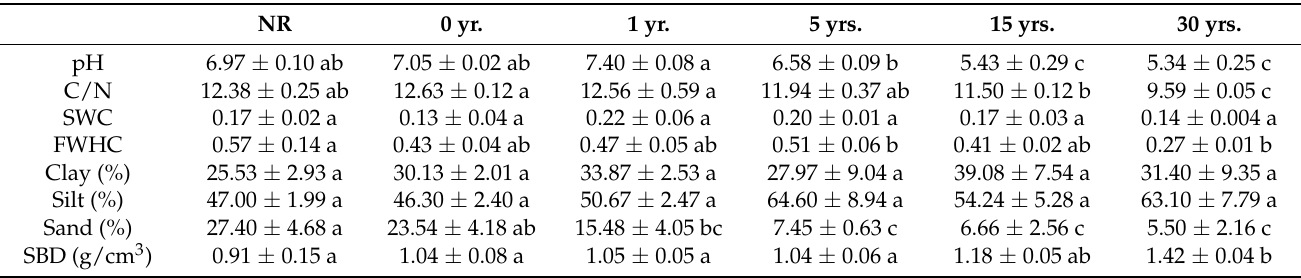
Table 1. Soil physical and chemical